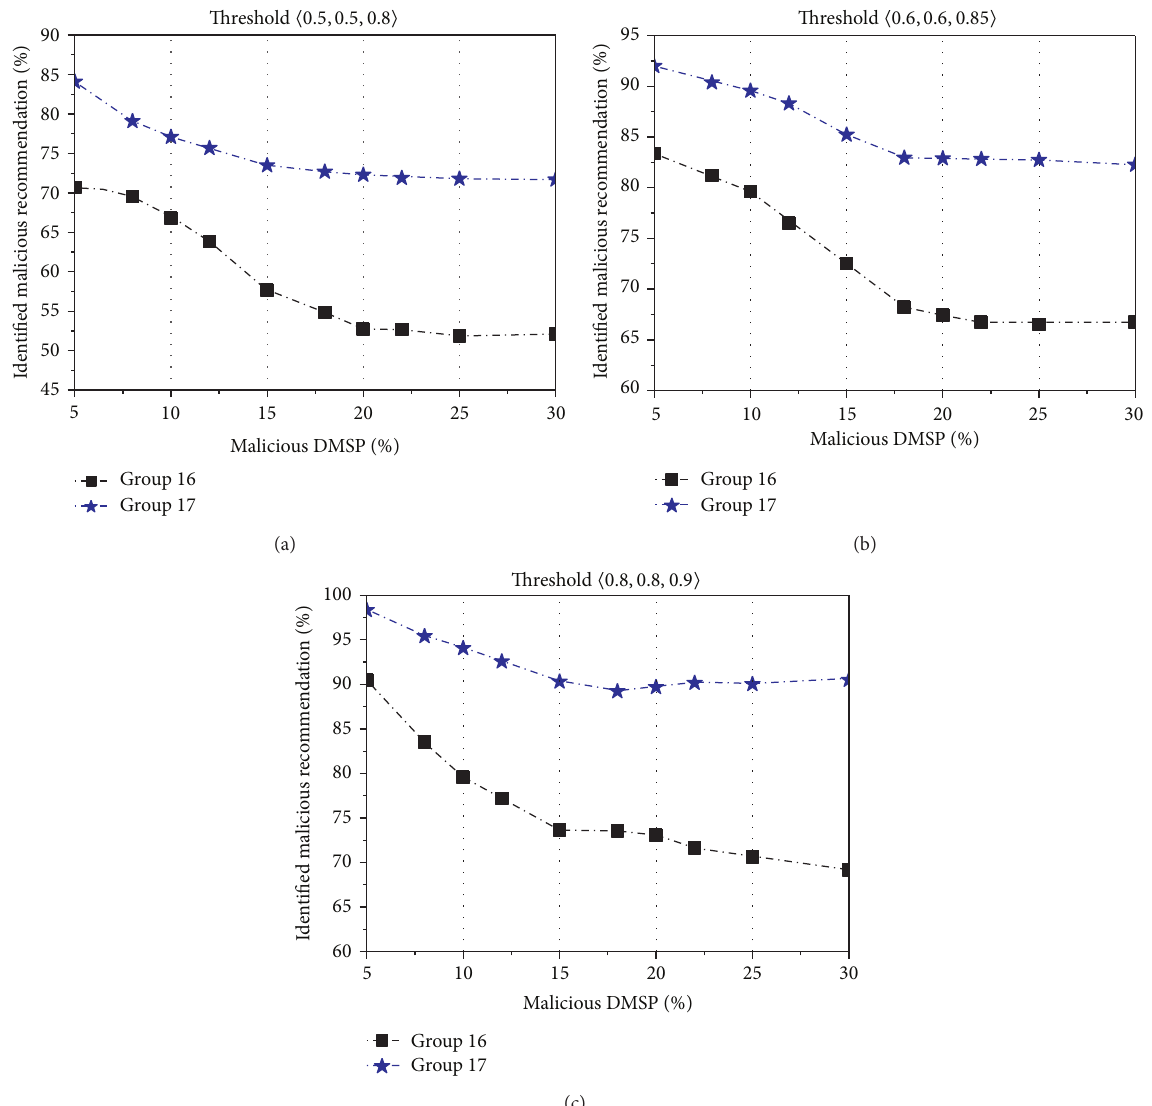
Figure 6: Identification of malicious